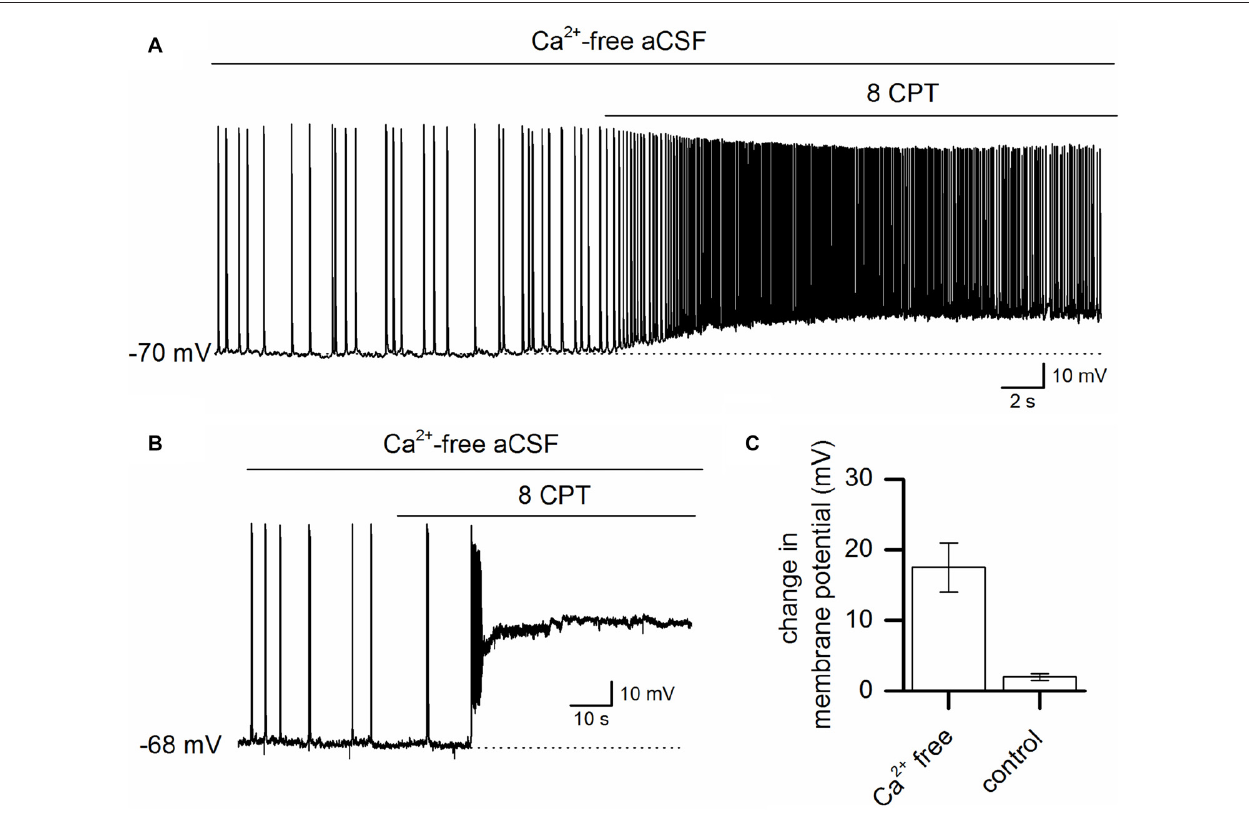
FIGURE 2 | Ca 2 + free-activity is suppressed by adenosine A 1 receptor activation. (A) Whole-cell recording from a pyramidal neuron during Ca 2 + -free activity illustrating the effect of blocking adenosine A 1 receptors with 8-cyclopentyltheophylline (8-CPT) (2 µ M). (B) Example recording from a pyramidal cell where the application of 8CPT (2 µ M) induced a large and rapid depolarizing shift in the membrane potential. The membrane potential remained depolarized for a long period (over 20 min). (C) The mean change (summarized for 8 cells, P < 0.001) in membrane potential produced by blocking A 1 receptors with 8CPT in resting conditions (normal aCSF) and in Ca 2 + free